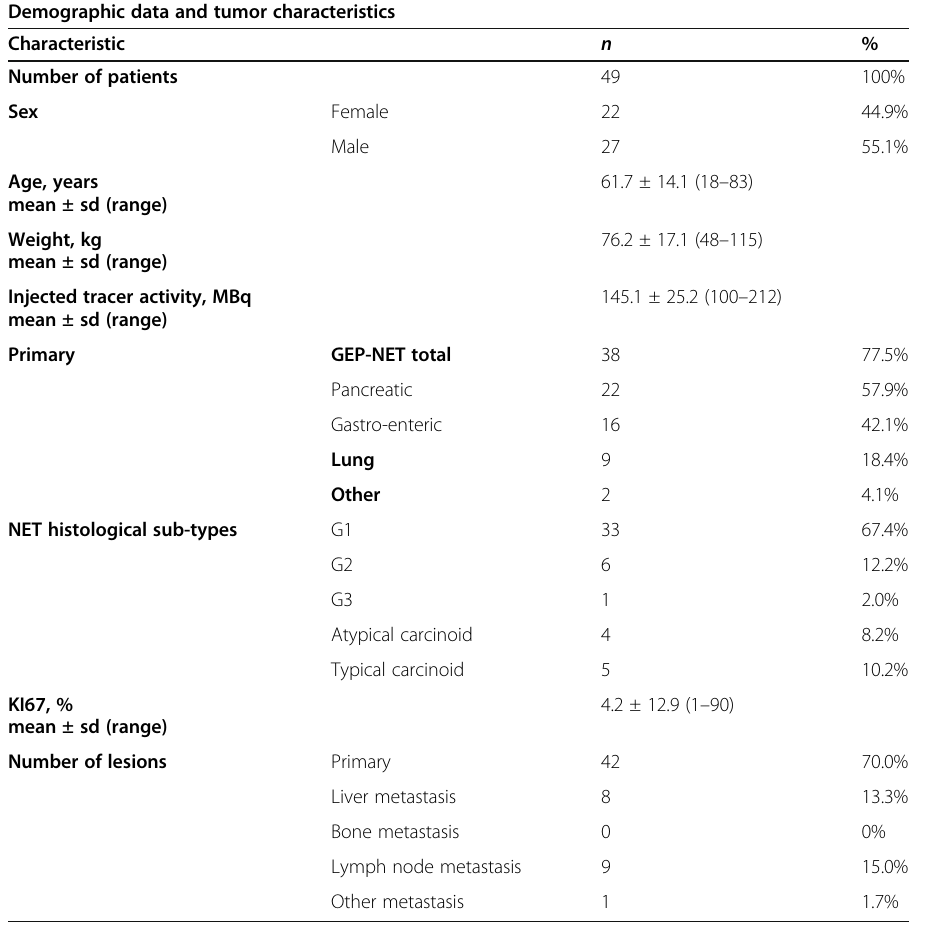
Table 1 Demographic data and NET characteristics of study subjects (values are given as mean ± standard deviation and